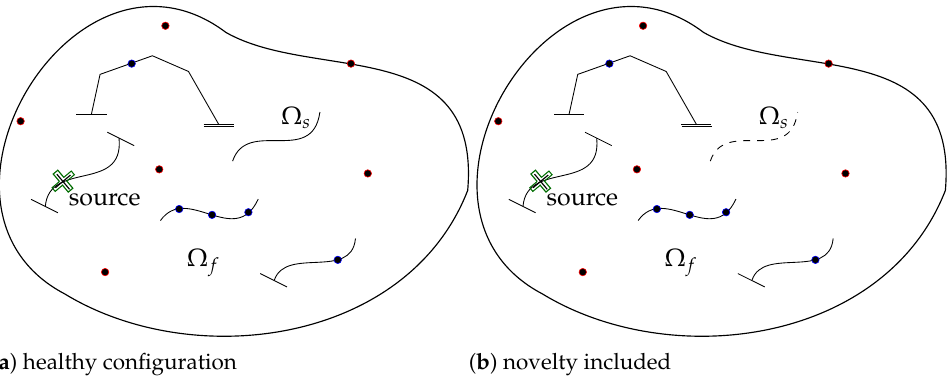
Figure 1. A schematic representation of the computational time reversal experimental set-up. On the left, a schematic of the healthy configuration is shown. On the right the same configuration is presented, including the novelty on the structure indicated with the dashed-line beam. Red and blue dots are assumed to be pressure and kinematic response recorders,